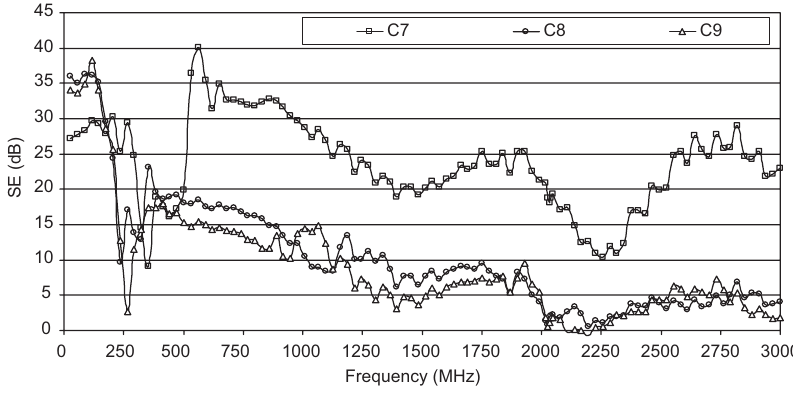
Figure 8 EMSE values of C7 to C9 composite